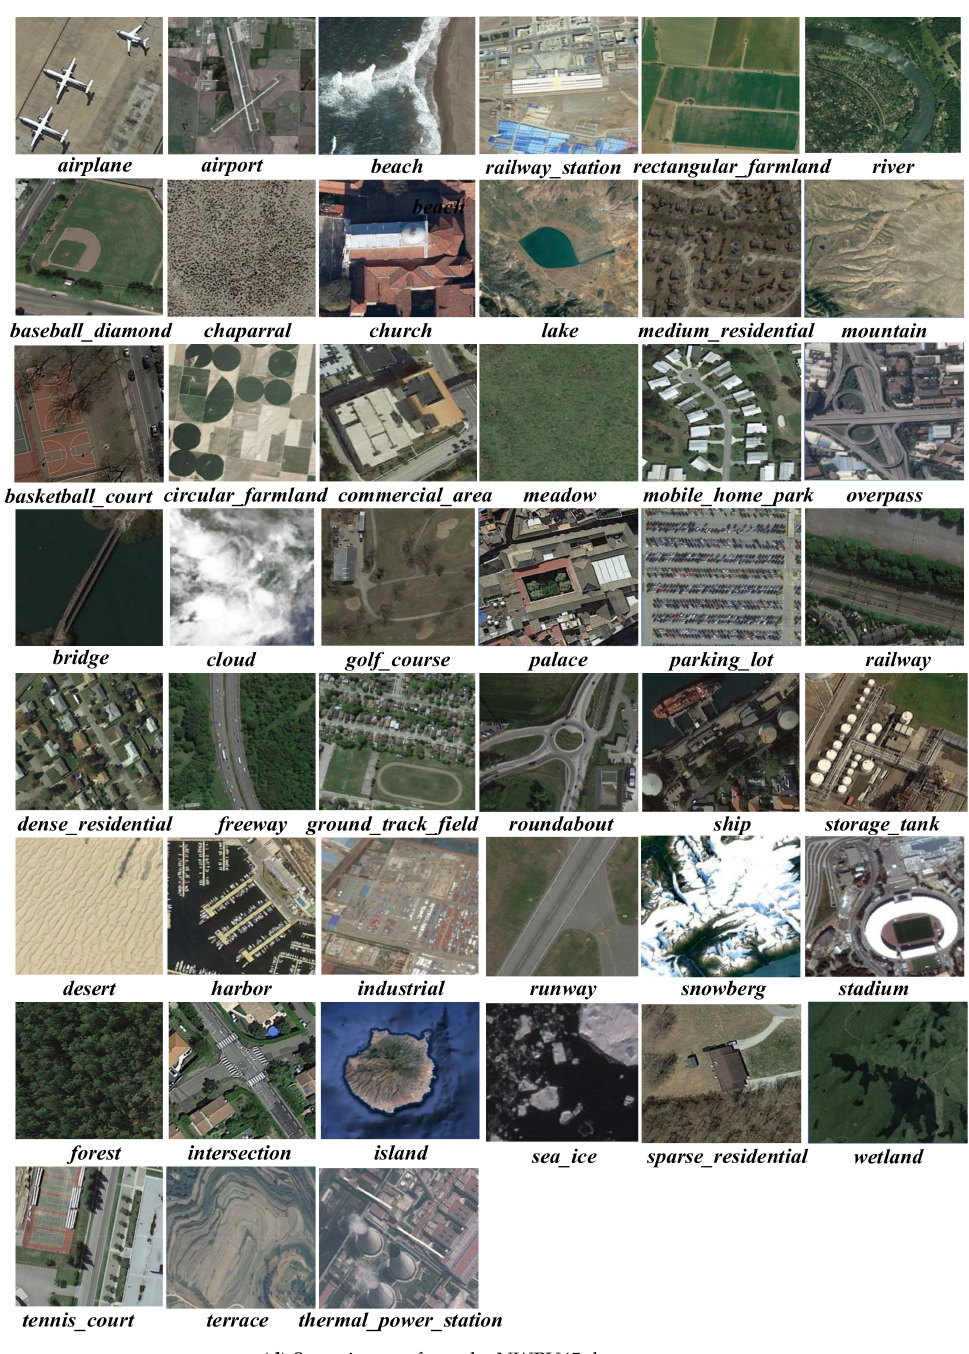
Figure 5. Different scene images in four datasets. ( a ) Scene images from the UCM21 dataset. ( b ) Scene images from the RSSCN7 dataset. ( c ) Scene images from the AID dataset. ( d ) Scene images from the NWPU45